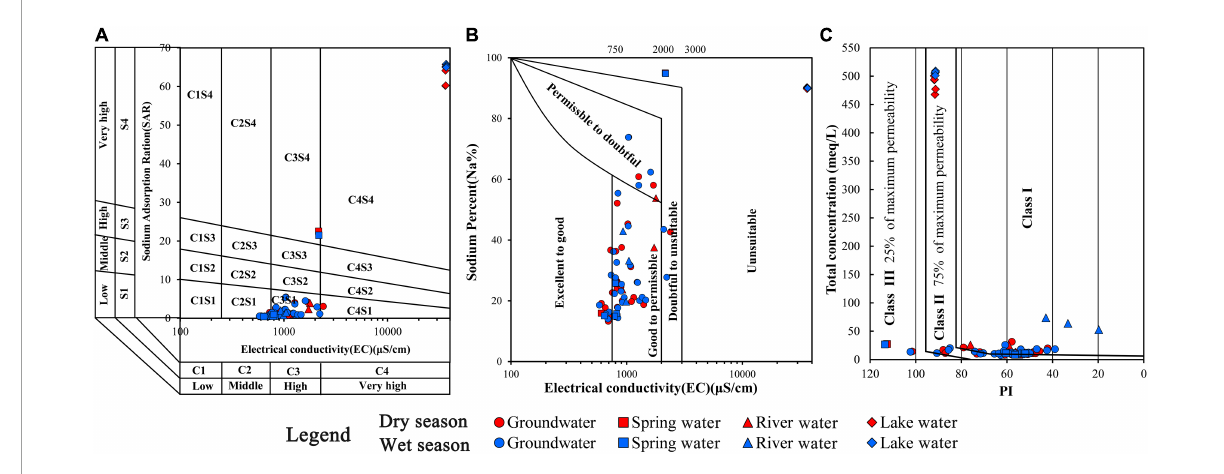
FIGURE5 Classification of irrigation water quality in the Daihai Lake Basin according to USSL (A) , Wilcox (B) , and PI (C)